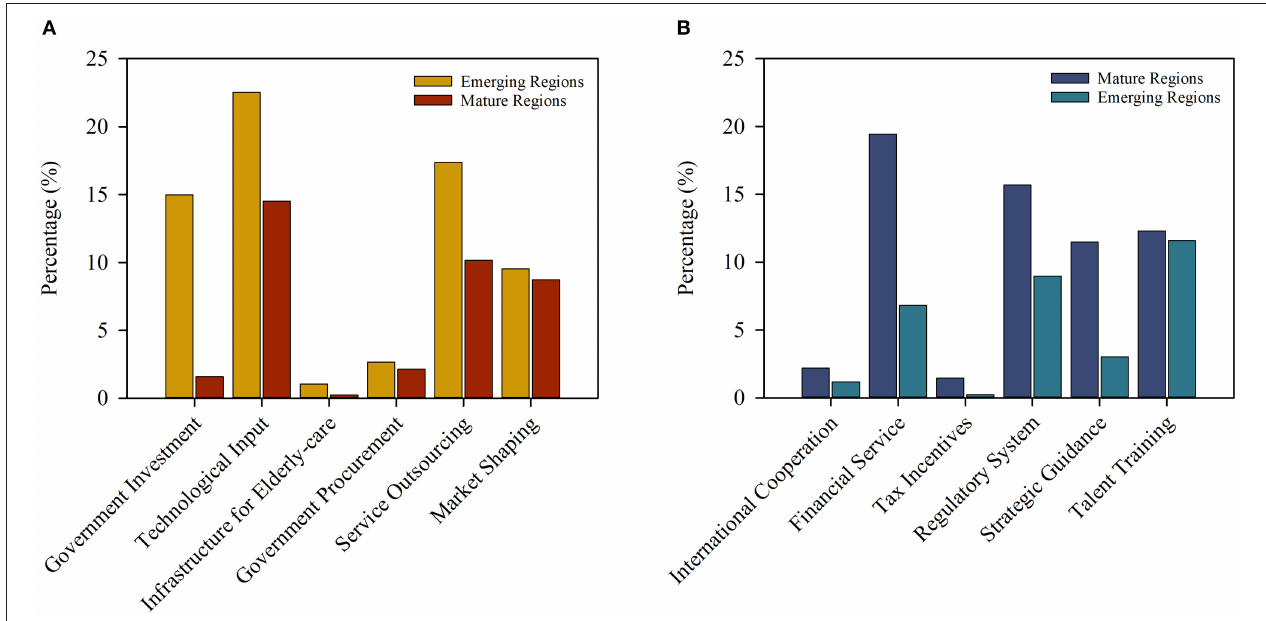
FIGURE 7 | The usage of elderly care policy instruments in mature and emerging regions in China. (A) Policy instruments with higher usage rates in emerging regions. (B) Policy instruments with higher usage rates in mature